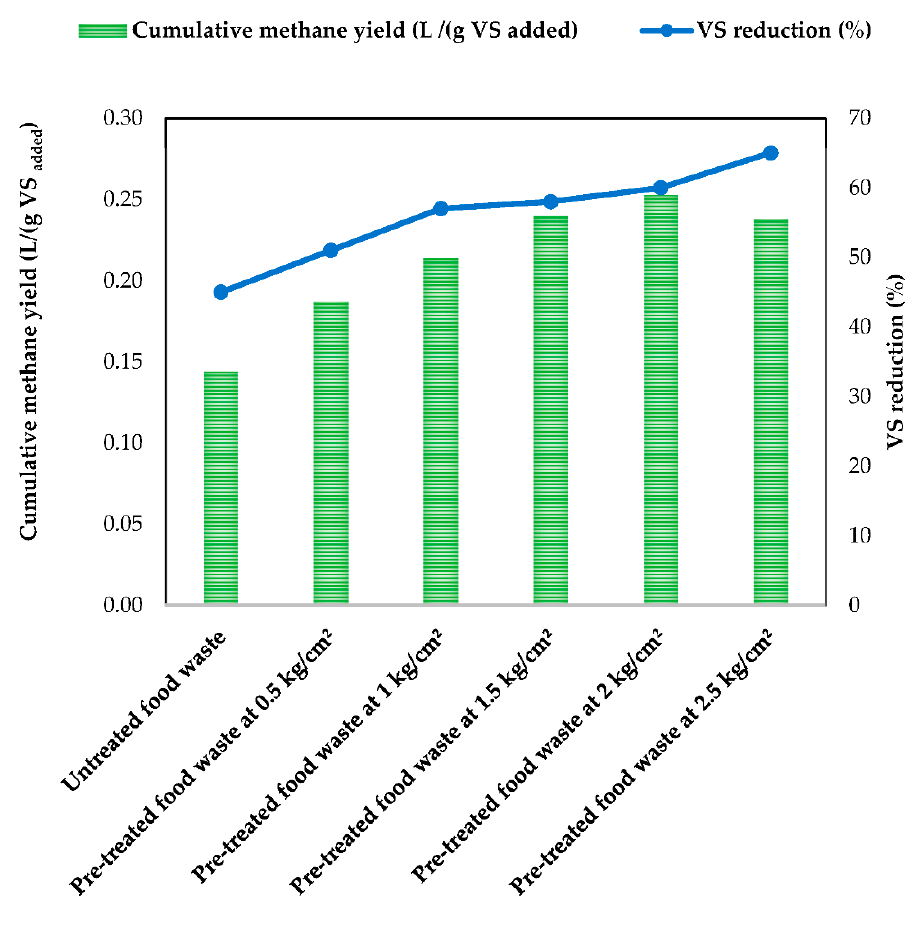
Figure 3. Cumulative methane yield in the reactors operated with untreated and pretreated food waste at different pressures.